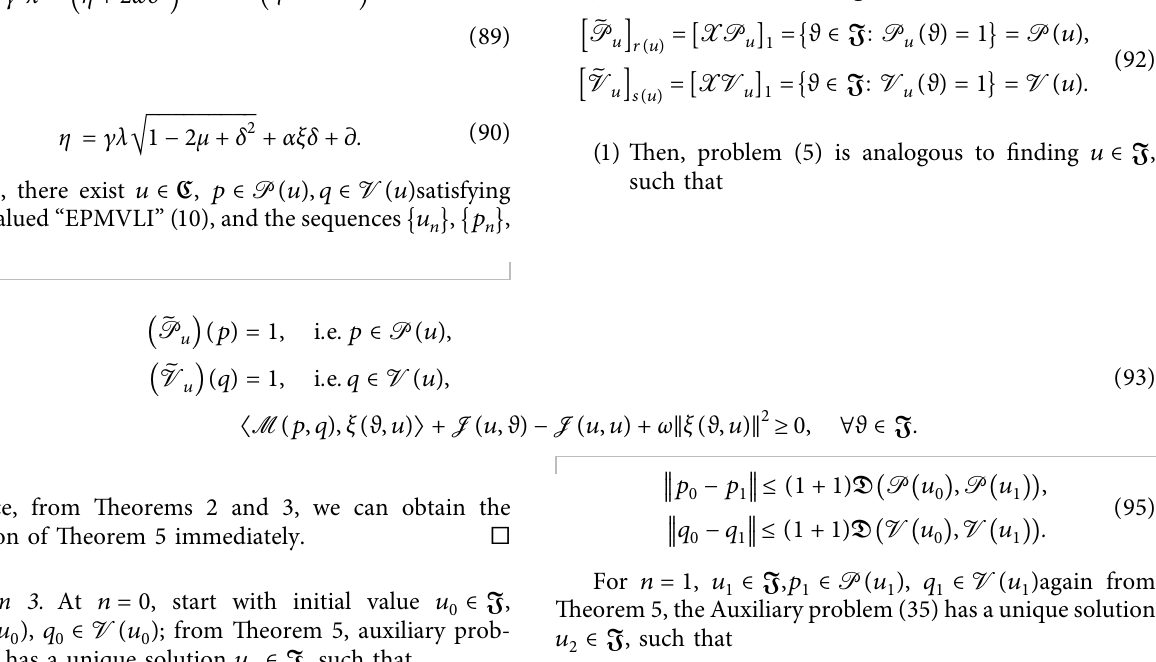
Algorithm 3. At n � 0, start with initial value u